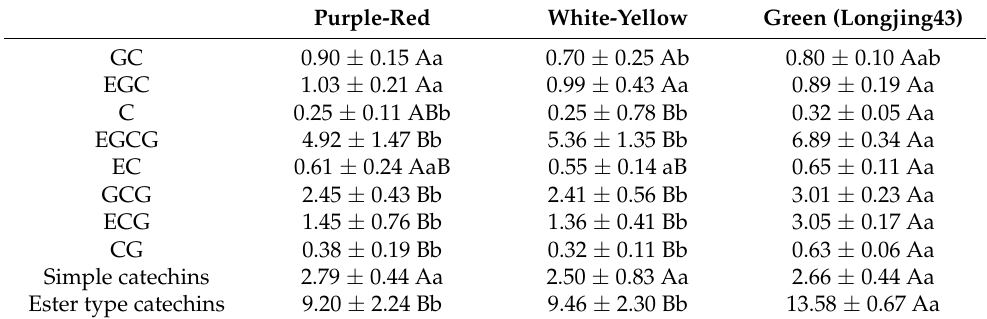
Table 1. Simple catechin and ester-type catechin contents of three different colored-leaf tea types *.